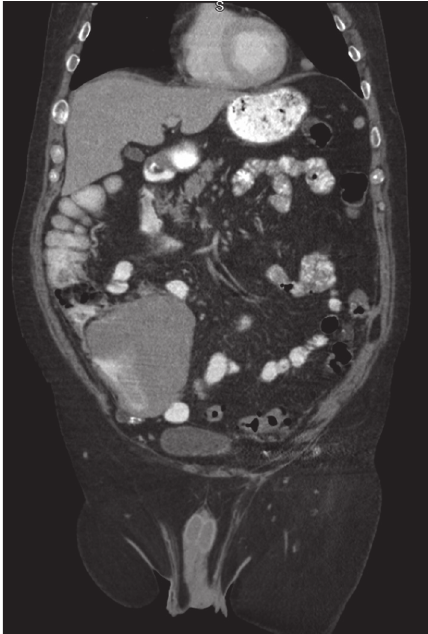
Figure 4: Circumferential cecal mass resulting in narrowing of the terminal ileum and cecal